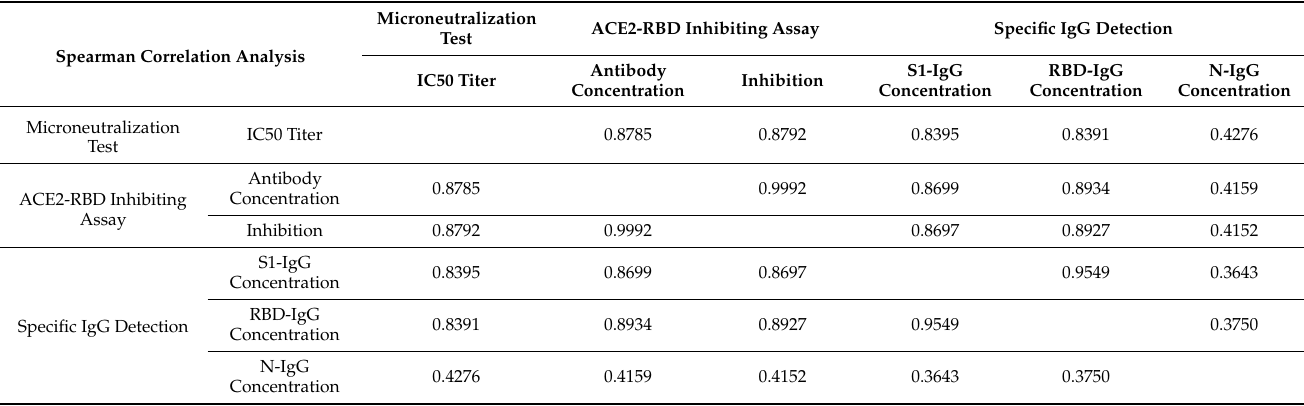
Table 1. Correlation among ACE2-RBD-inhibiting antibody, SARS-CoV-2 specific IgG and microneutralization test results of the sera from 119 convalescent patients.